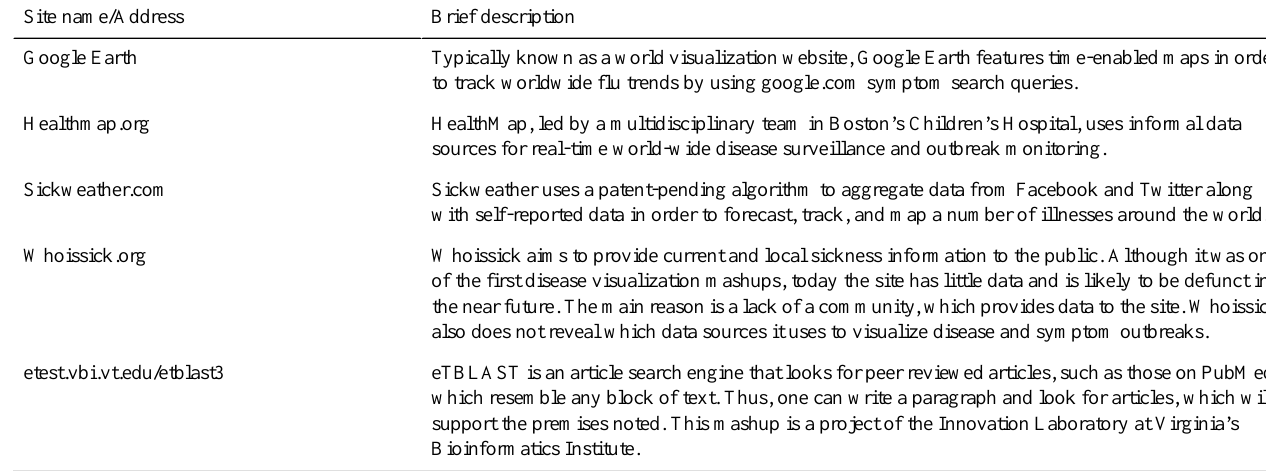
Table 2. Some well-known health-related mashups.